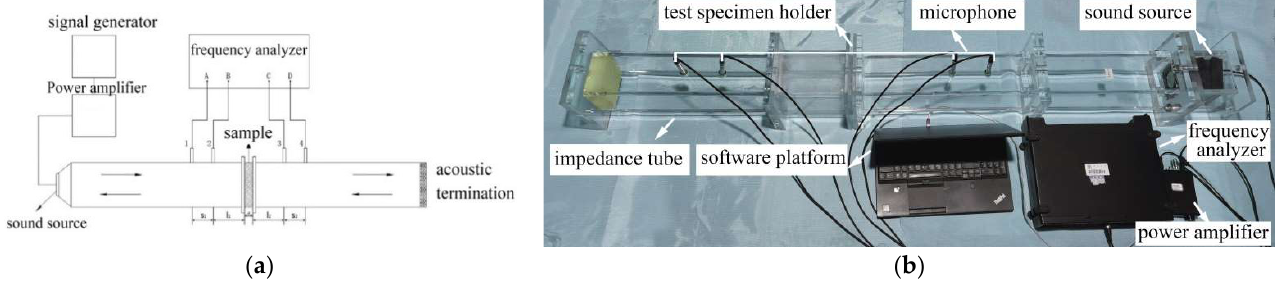
Figure 3. ( a ) Schematic diagram of experimental measurement system for transmission loss of composite partition structure; ( b ) Field drawing for standing wave tube test measurement field drawing.